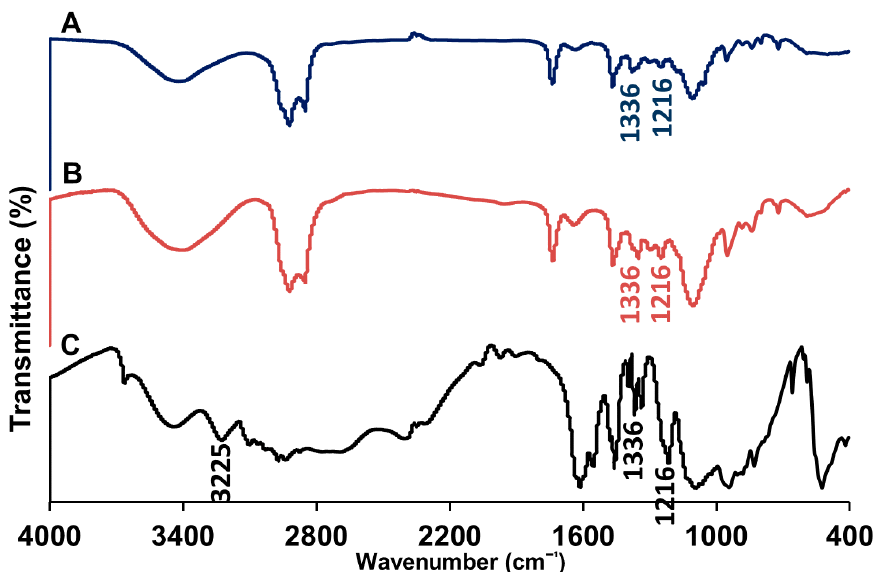
Figure 3. Fourier transform-infrared spectra of chloroquine-loaded niosomes (A), empty niosomes (B), and chloroquine (C). A TGA graph of cholesterol, chloroquine, Span ® 60, empty niosomes, and chloro-